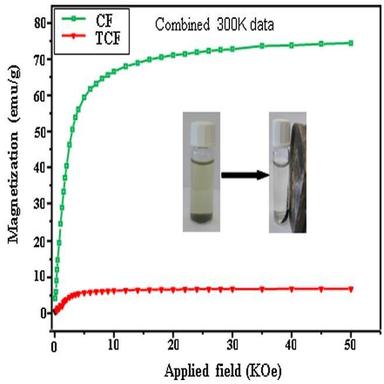
Magnetization curves of CF and TCF nanocomposites; the inset shows the easy separation of photocatalyst using an external magnet.